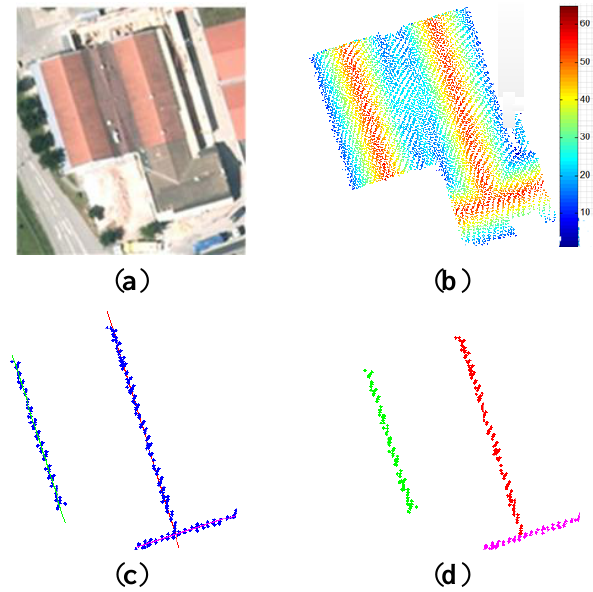
Figure 1. Detection of roof ridges using RANdom Sample Consensus (RANSAC) line detection. ( a ) Aerial photo from Google Map. ( b ) point clouds of building sorted by height. ( c ) linear component detected by RANSAC. ( d) detected roof ridges.